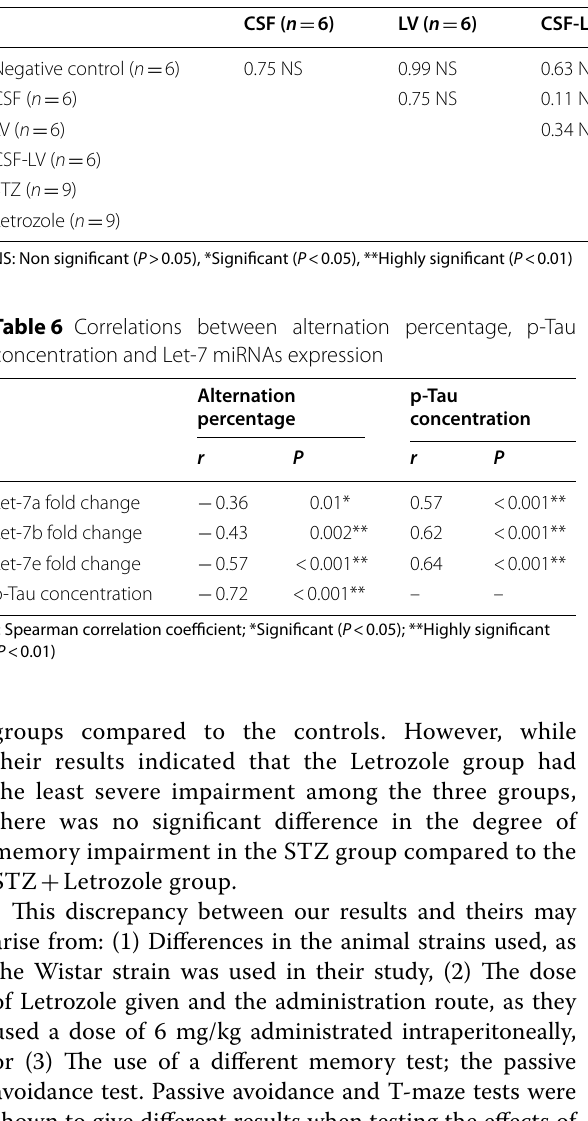
Table 5 LSD for Let‑7e fold change among different studied groups